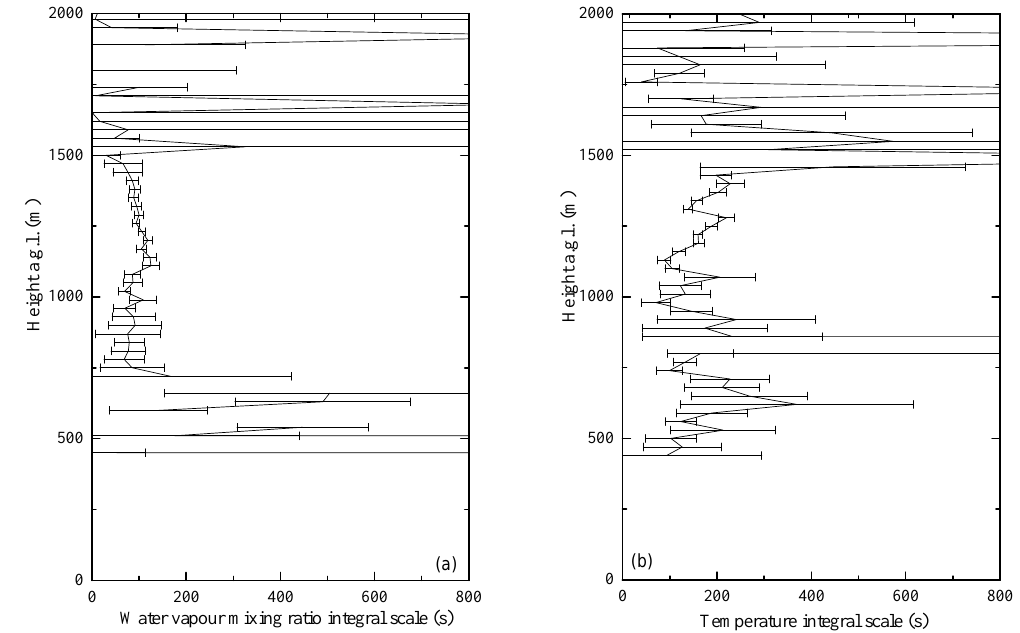
Figure 9. Integral scale of water vapour mixing ratio (a) and temperature fluctuations (b) computed for the same time interval considered in Fig. 4.